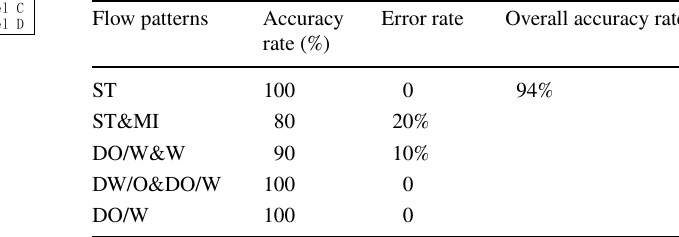
Table 1 Test results of test